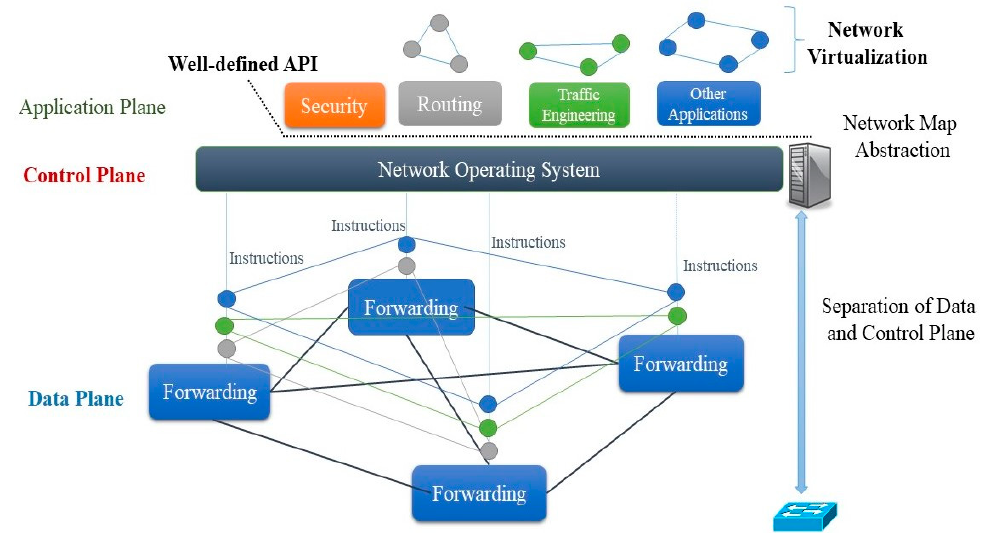
Figure 5. General architecture of a software defined network.